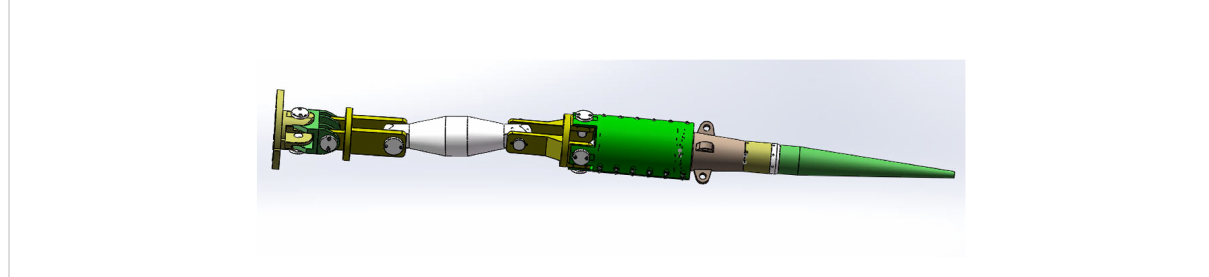
FIGURE 7 Flexible connection joints including the universal joint, slip ring and E/O electronic cabin.